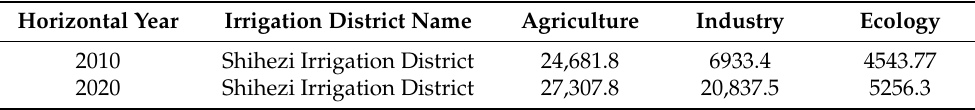
Table 1. Water demand of the Shihezi Irrigation District in 2020 (10 4 m 3